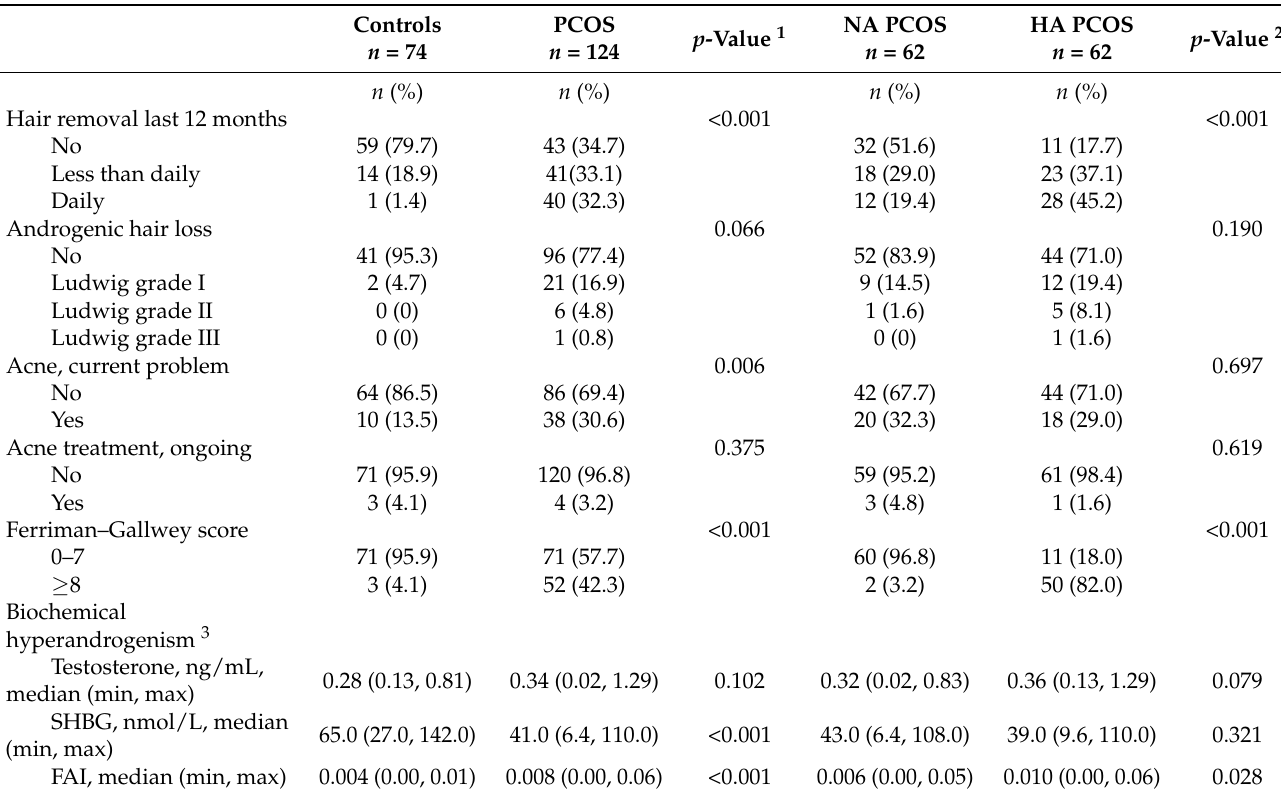
Table 2. Androgenic symptoms, treatment and biochemical hyperandrogenism at the follow-up assessment in women with PCOS and controls.